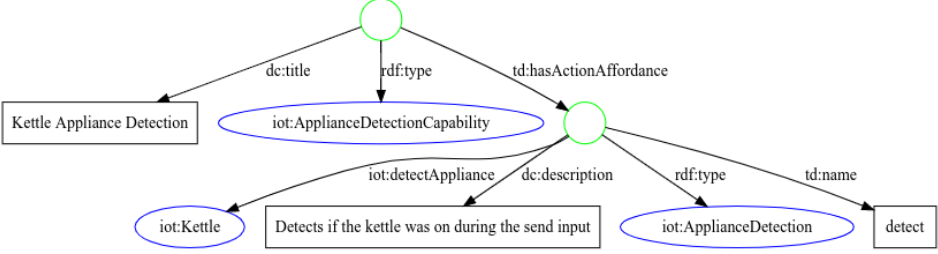
Figure 9. Excerpt of a Thing Description template for the kettle appliance detection